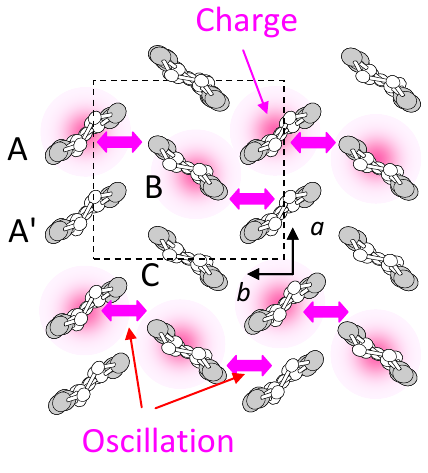
Figure 16. Schematic presentation of the electronic oscillation with a period of 18 fs in α-(ET) I . The oscillation occurs respectively between A (charge-rich) and B (charge-rich) 2 3 sites and between B (charge-rich) and A′ (charge-poor)